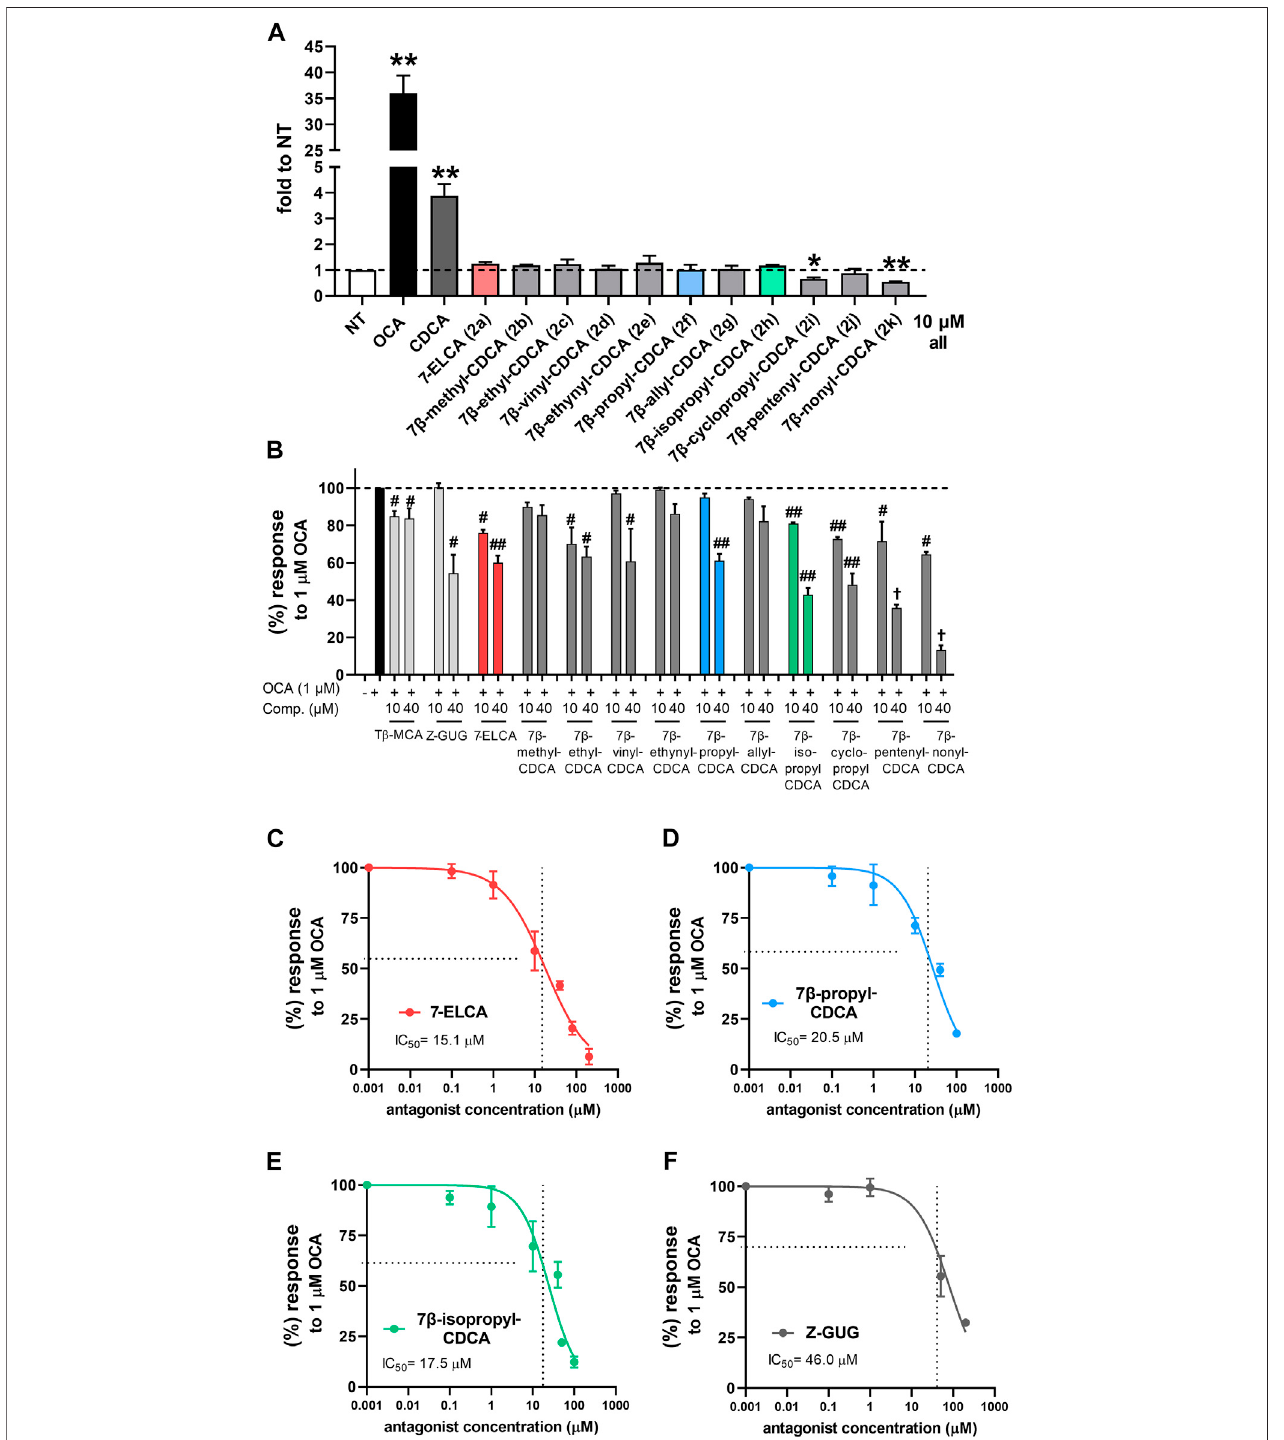
FIGURE 3 | Interaction of 7-alkylated derivatives of CDCA and 7-ELCA with human FXR in luciferase reporter gene assays. HepG2 cells were transiently co- transfected with the luciferase FXRE-luc construct and with expression pSG5-hFXR, pSG5-hRXR α , and pRL-TK vectors. Cells were treated with indicated concentrations for 24 h alone (A) , an agonistic mode) or with 1 µM OCA as an FXR agonist (B – F) , an antagonistic mode) . FXR agonist CDCA and antagonists T β -MCA andZ-GUGwereusedasknownFXRligands.Datawerenormalizedto Renilla luciferaseactivityandareexpressedrelativetothoseofcontrolnontreatedcells(NT). Values are presented as the means ± SD of three independent experiments performed in biological triplicates ( n (cid:1) 3). ** p < 0.01 vs. NT; # p < 0.05, ## p < 0.01 vs. 1 µM OCA. IC 50 values were calculated using concentration-response curves nonlinear fi tting in GraphPad software.